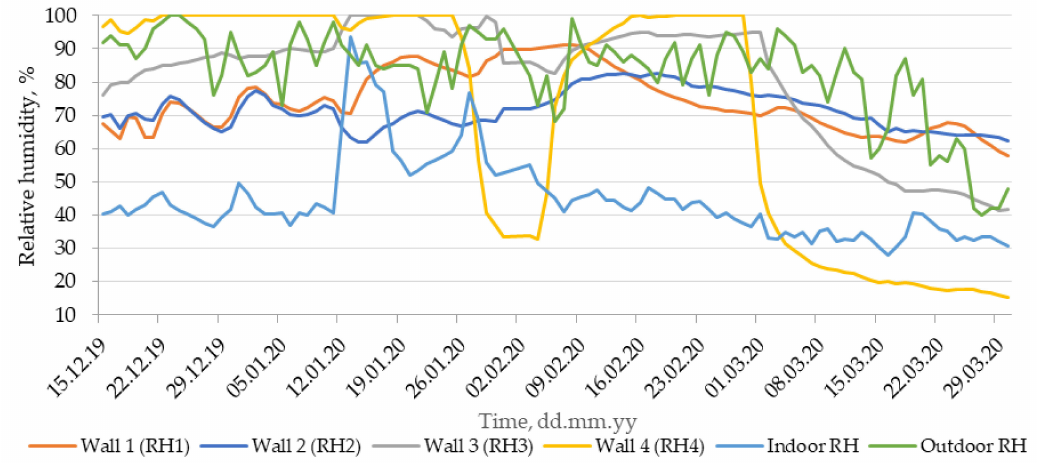
Figure 8. Test wall relative humidity. Reproduced with permission from [11].